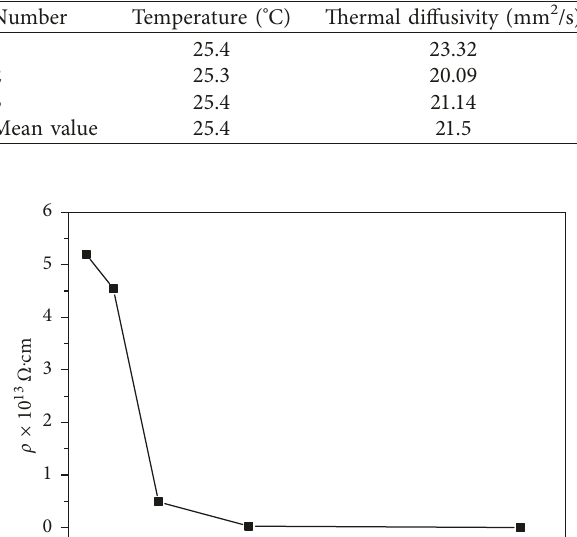
Figure 1: (a, b) The cross-sectional morphology of the specimen; microcracks are marked with red circle; pores accumulate at the surface of the MAO layer. (c) The surface morphology of the specimen. Table 2: Thermal diffusivity result for the composite.